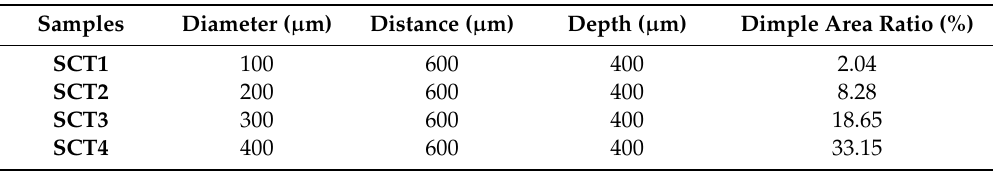
Figure 1. Morphologies of the textured surface with 300 μ m dimples: ( a ) before friction, ( b ) after friction, ( c ) profile of a dimple. Table 1. Details of dimples in the coated steel.